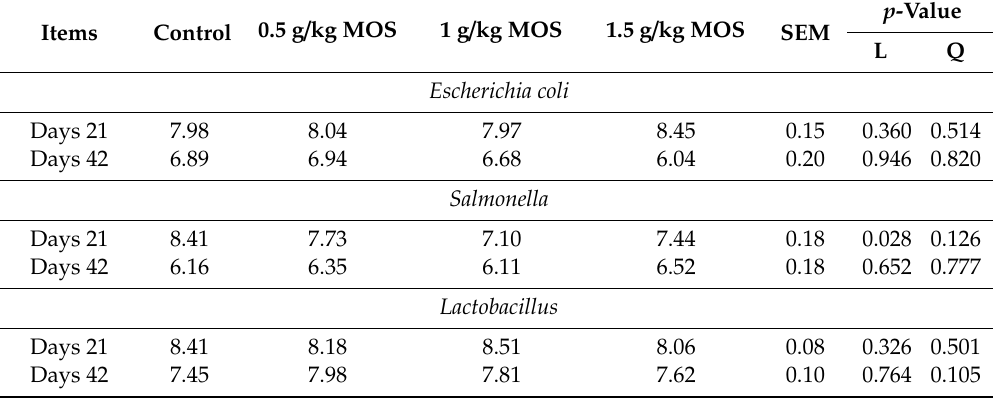
Table 4. Microflora population in the cecal content of Partridge Shank chickens fed diets supplemented with or without MOS (log CFU / g content).